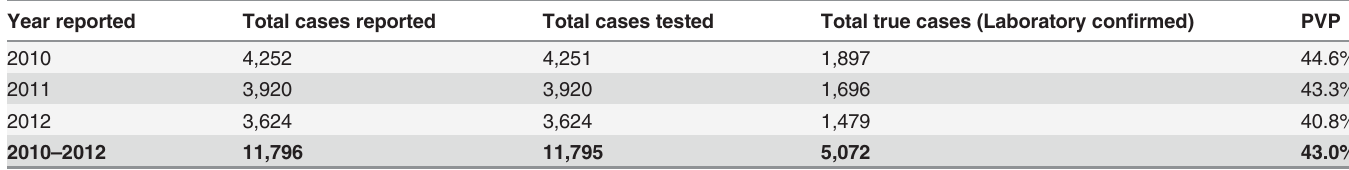
Table 2. Estimates of predictive value positive of the National Disease Surveillance System for dengue fever by year — Taiwan, 2010 –